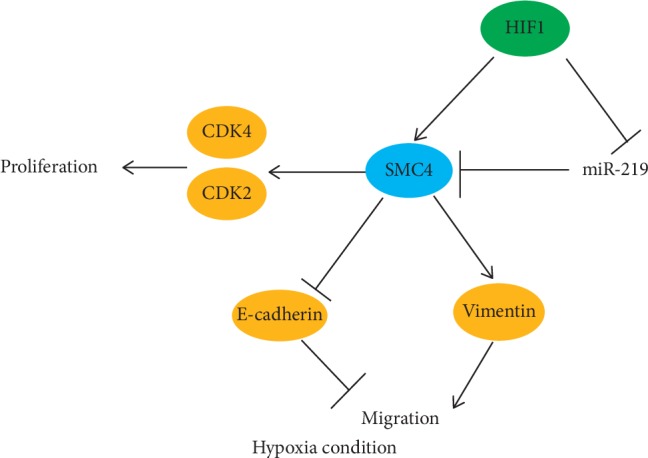
HIF-1-miR-219-SMC4 axis regulates proliferation and migration of HCC under hypoxic condition.